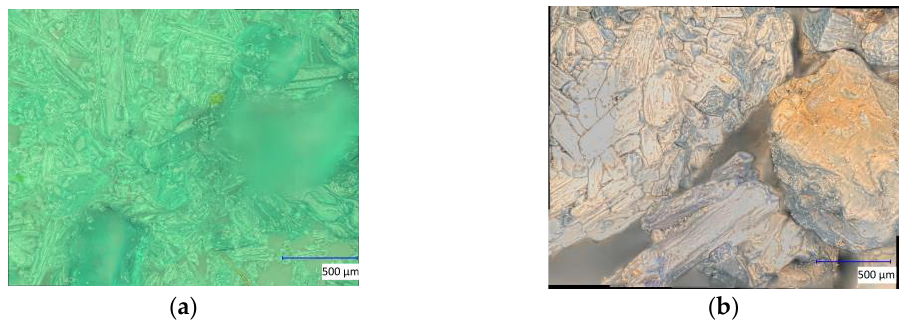
Figure 10. Microscope images of CuCl 2 crystals before ( a ) and after the one-hour Varigon plasma treatment at a low pressure ( b ). Picture ( b ) shows the plasma-induced color change as an indicator of a surface alteration caused by plasma reduction processes.